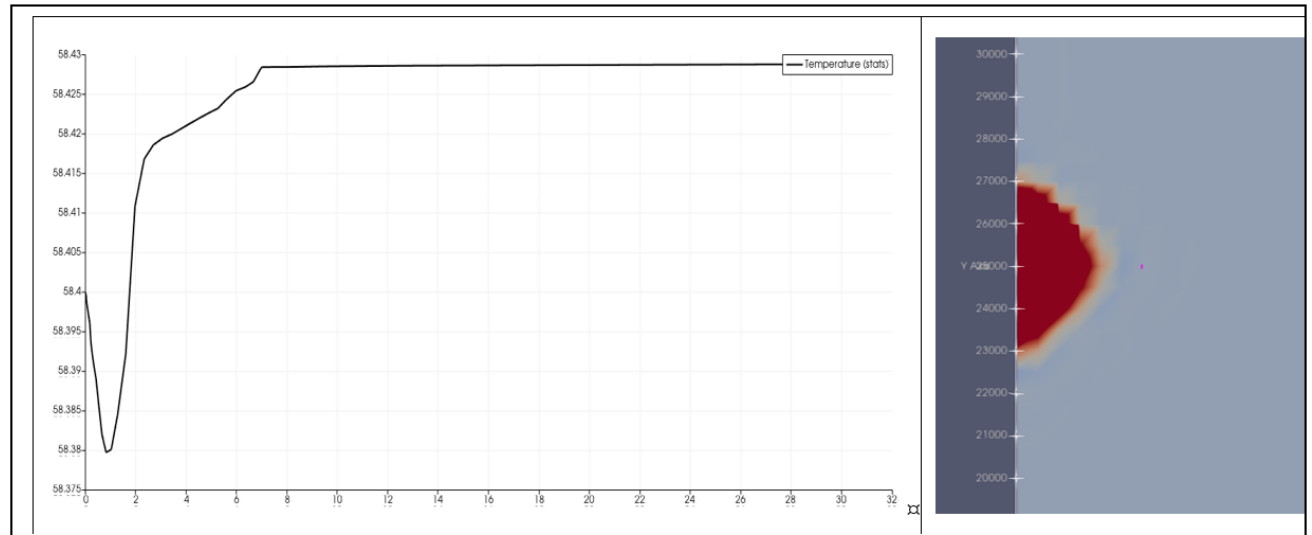
Figure 5. The simulated 30-day temperature profile at grid point ( x = 30 m, y = 250 m, and z = −1530.625 m), corresponding to the location where the Frio Pilot observation well temperature sen- sor was placed. In the left plot, the y -axis is temperature in °C and the x -axis is time in days. The right image is a plot of temperature on the x-y plane at z = −1530.625 m. In the left plot, one can see the early arrival of a relatively lower temperature, low-pH diffusion front followed by a relatively higher temperature, high-alkalinity sweep front.